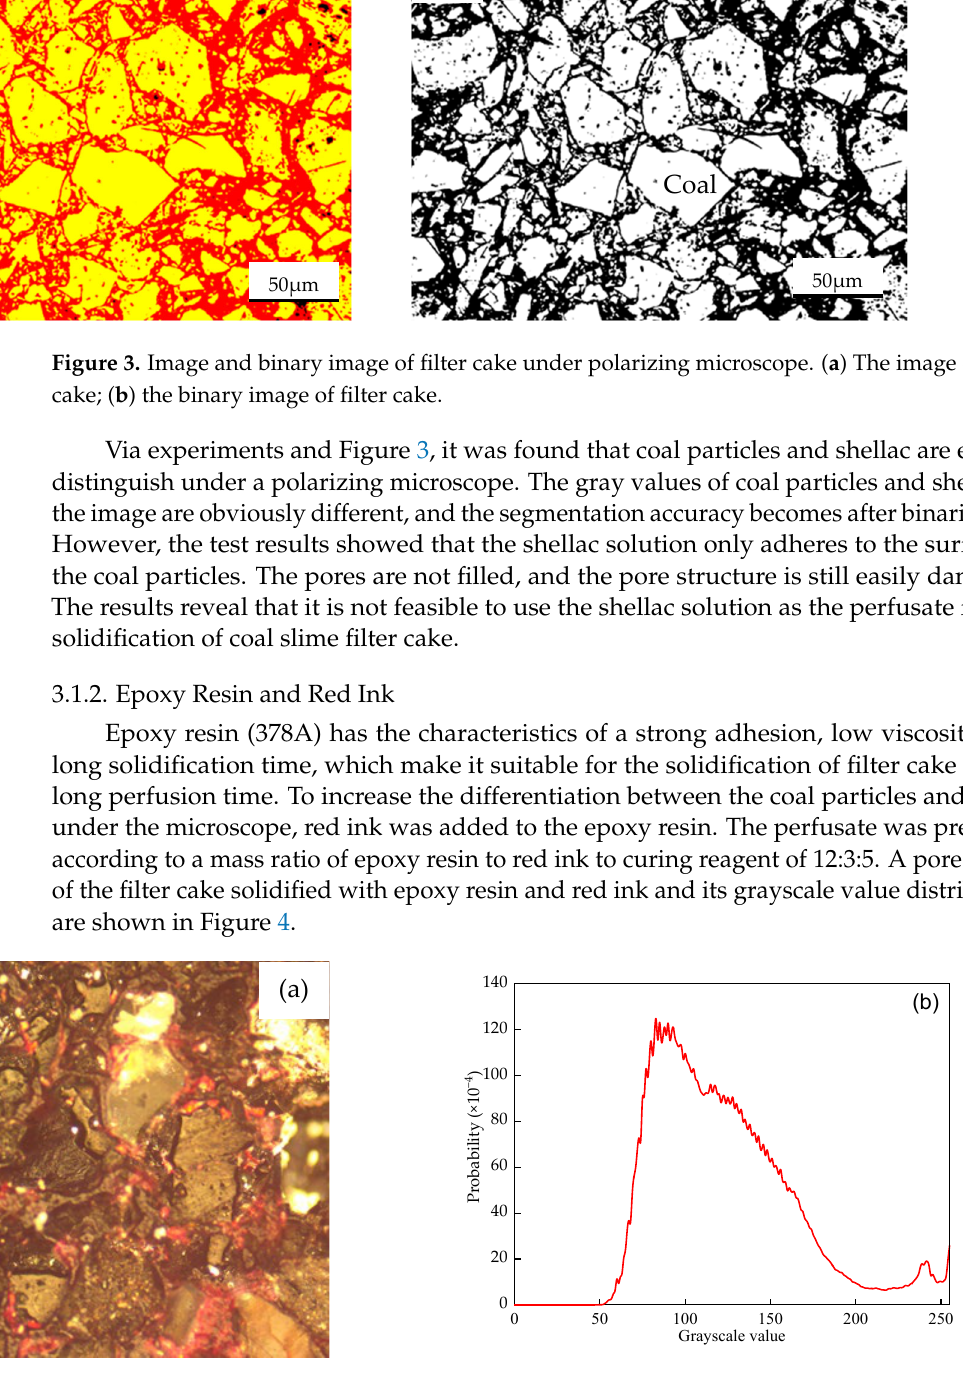
Figure 4. Pore image and grayscale value distribution of the filter cake solidified with epoxy resin and red ink. ( a ) Pore image of the filter cake; ( b ) the grayscale value distribution. The grayscale value distribution of the pore image reflects the probability that a pixel point with a certain grayscale value occupies the total pixel point. The more notable the difference in grayscale value between the coal particles and pores is, the higher the seg- mentation accuracy will be in the case of image binarization and the more accurate the measurement of the filter cake pore structure will be. As shown in Figure 5, the color dif- ference between the coal particles and pores in the pore image is not notable, and the color depth of the pores is uneven. The grayscale distribution curve of the filter cake pore image only exhibits one main peak, and there is no notable difference between the coal particle and pore grayscale values. The results show that the epoxy resin and red ink combination is not feasible to be used as the perfusate for the solidification of coal slime filter cake. 3.1.3. Epoxy Resin and Colorant Colorant has a good stability, dispersibility and strong coloring power and is soluble in epoxy resin. In this paper, four kinds of colorant, namely, black, blue, yellow, and red, were studied. The colorant was added to the epoxy resin, and the perfusion solution was prepared according to a mass ratio of epoxy resin to colorant to curing reagent of 12:3:5. The pore image of slime filter cake cured by epoxy resin and colorant is shown in Figure 5. The Figure 5 shows that when black, blue, and yellow colorants are added to the epoxy resin, the difference between the coal particles and pores in the pore image is small. When red colorants are added to the epoxy resin, the difference between the coal particles and pores is notable. The preliminary surface of the red colorants can improve the differ- ence between the coal particles and pores. To further study the effect of the colorants on the image binarization segmentation accuracy, grayscale value distributions of the pore images obtained by perfusing coal slime filter cakes with epoxy resin and yellow colorant, epoxy resin and red colorant were generated, as shown in Figure 6.